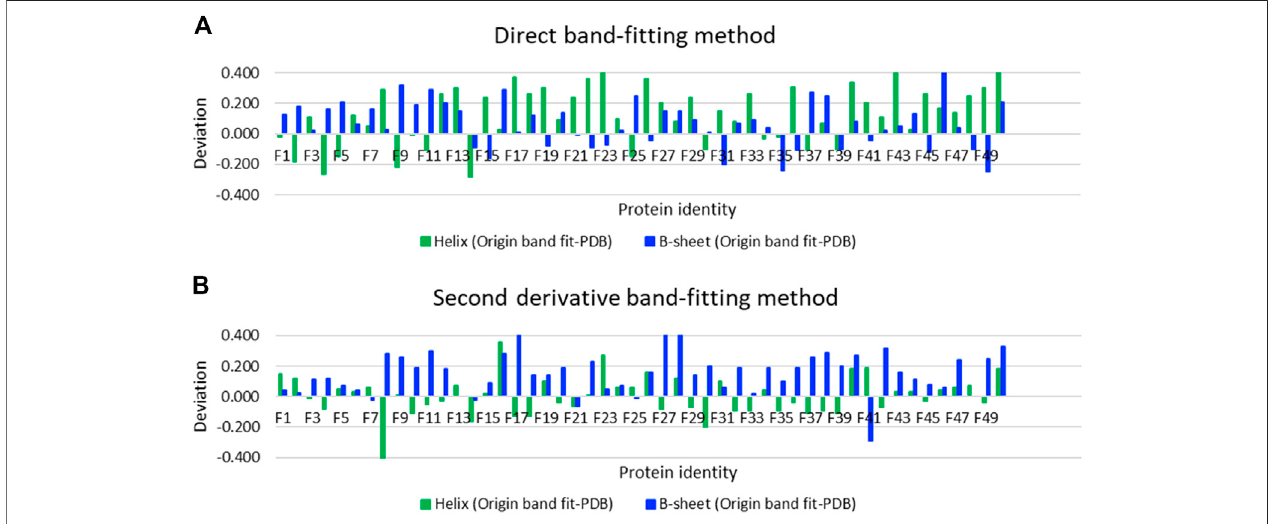
FIGURE 4 | Deviations of secondary structure prediction from PDB structures for helix and β -sheet for the Amide I band of the 50-protein fi lm reference set presented in order of decreasing helix content from left to right for (A) direct Gaussian band- fi tting and (B) the second derivative fi tting approach reported in reference (Yang et al., 2015). See Supplementary Material for protein identities. Deviations of the Other category deviations are minus the sum of helix and β -sheet